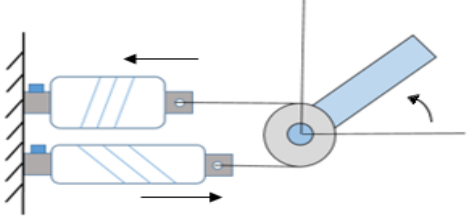
Figure 6. Schematic diagram of the drive of robotic arm (2nd, 3rd, and 4th axes).